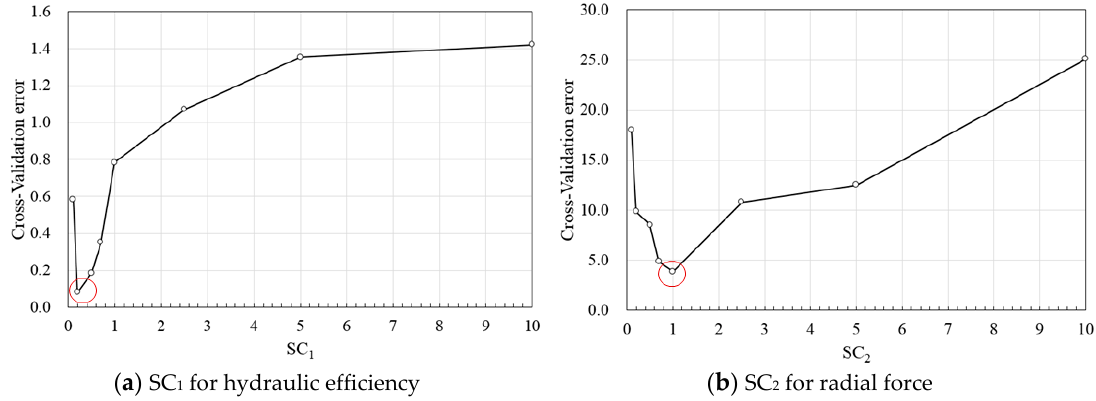
Figure 7. Cross-validation error vs. Spread constant (SC) value.